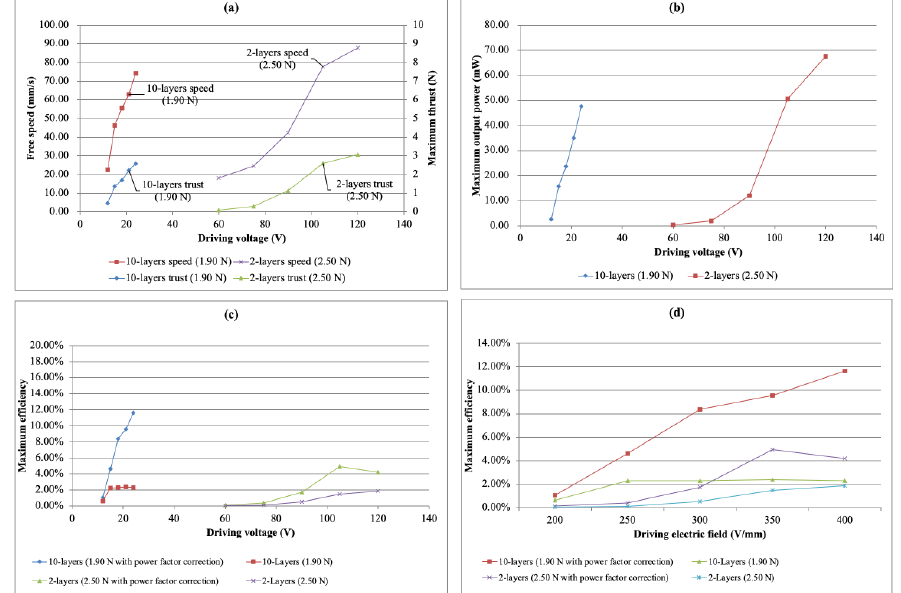
Figure 19. The performance comparison of the simple bimorph USM and the multi-layer bimorph USM. ( a ) Driving voltage vs. free speed and driving voltage vs. maximum thrust, ( b ) maximum output power vs. driving voltage, ( c ) maximum efficiency vs. driving voltage and ( d ) maximum efficiency vs. driving electric field.